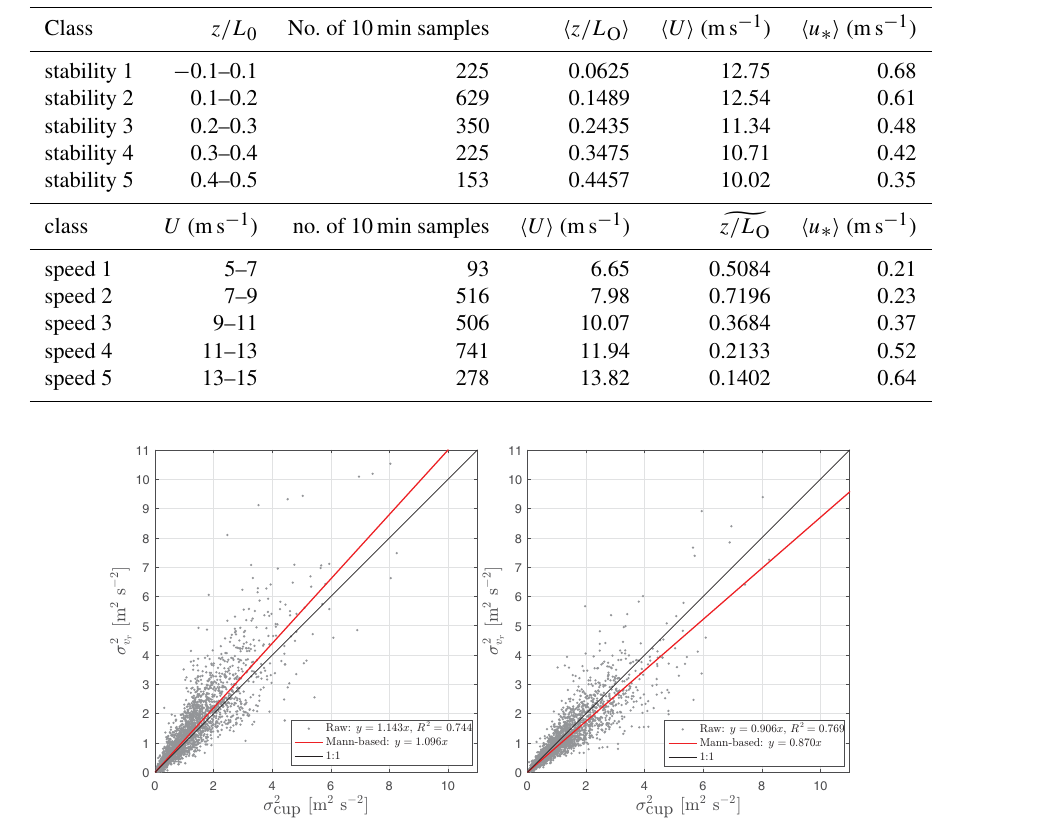
Table 1. Atmospheric-stability and wind-speed classes and ranges based on the cup- and sonic-anemometers’ observations (see text for details). The ensemble-average values of the dimensionless stability, wind speed, and friction velocity per range are also provided. For the speed ranges we use the median of the dimensionless stability. z = 67m is here the mean height used for the dimensionless atmospheric- stability estimates.